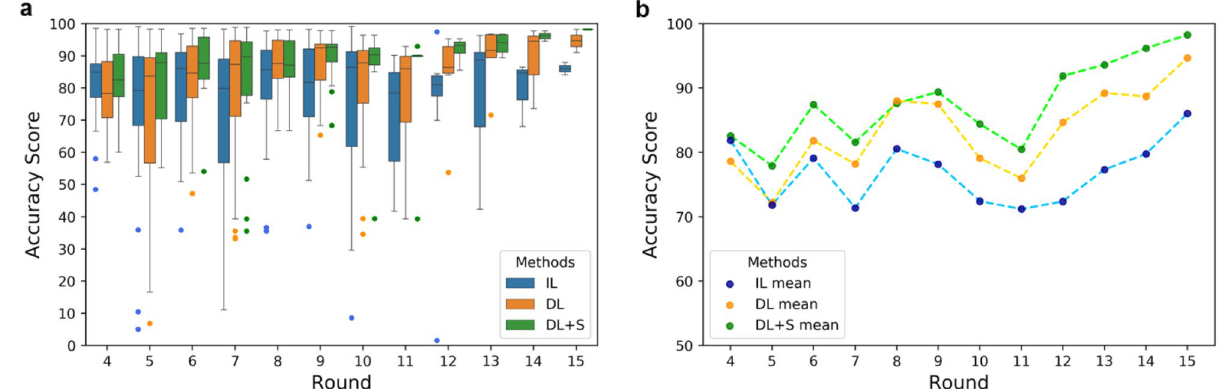
Figure 2. Comparison of accuracy scores ( R A ) of each method on all 30 subjects in each test round. ( a ) The accuracy score distribution in a box plot. ( b ) The mean accuracy scores in a line chart.